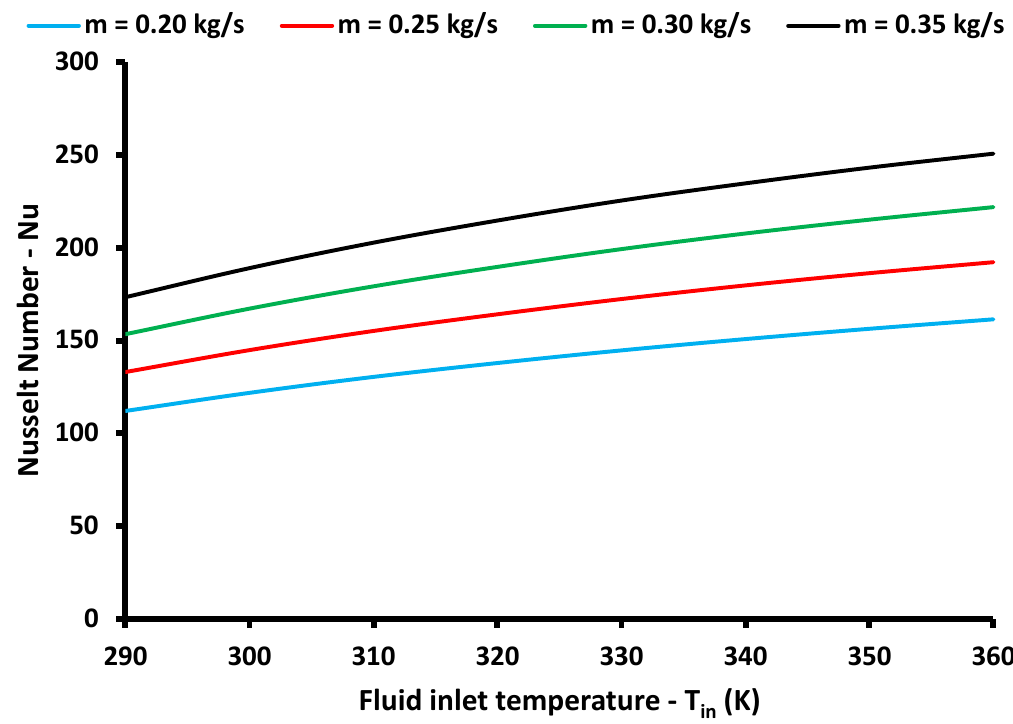
Figure 7. Nusselt number variation for the different operating scenarios in the reference case of the empty tube.